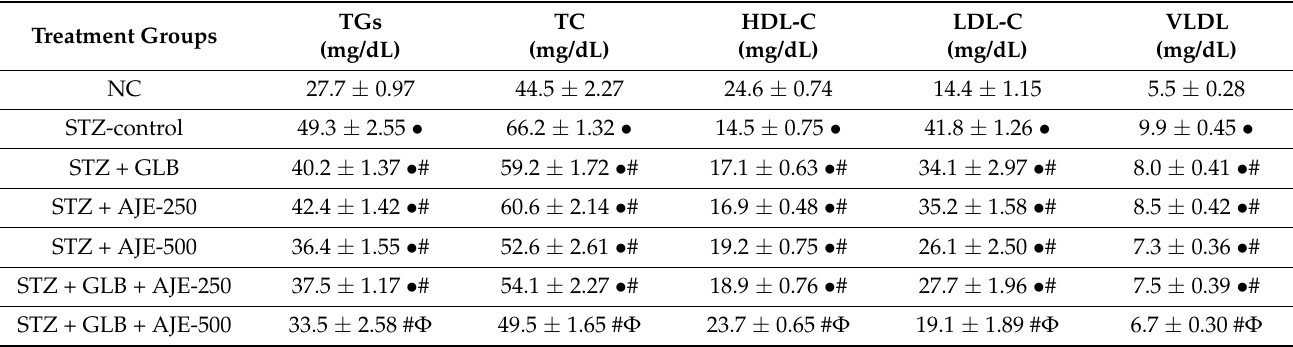
Table 6. Effect of GLB, AJE, and their combination on lipid profile in blood of STZ-diabetic rats after 8 weeks of the medication